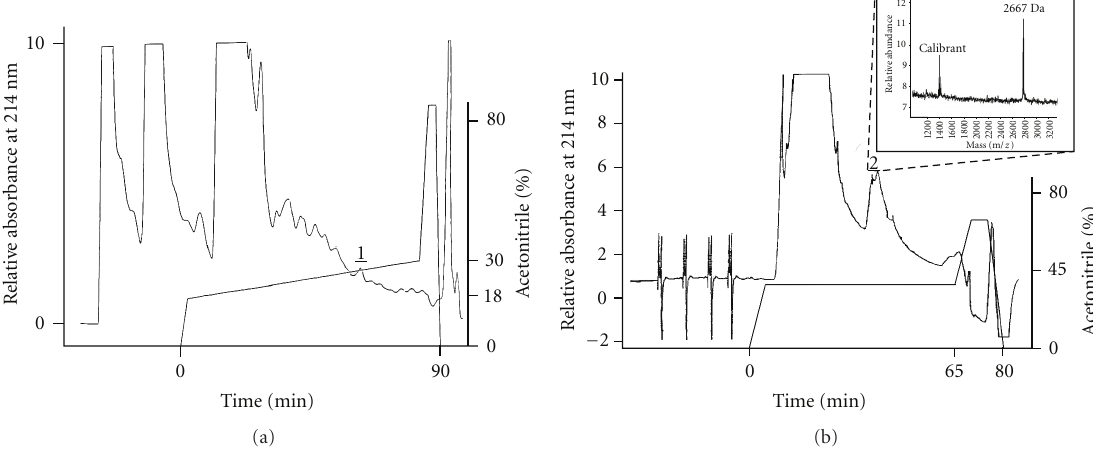
Figure 1: Reversed phase fractionation of salivaricin G32 preparations. (a) Representative C 8 reversed phase fractionation of concentrated XAD-2 fractions containing inhibitory activity against indicator organism Micrococcus luteus . Elution of the column was with a gradient of 18–30% acetonitrile at a flow rate of 1 mL · min − 1 with detection of absorbance at 214 nm. (b) C 18 reversed phase fractionation of pooled C 8 reversed phase fractionated samples having inhibitory activity as indicated in panel A by the solid bar labelled 1. Elution was with isocratic 45% acetonitrile (containing 0.1% TFA) over 60 minutes at a flow rate of 0.7mL · min − 1 . Active fractions (solid bar 2) from multiple runs were pooled then analysed by MALDI-TOF MS as indicated by the grey insert.